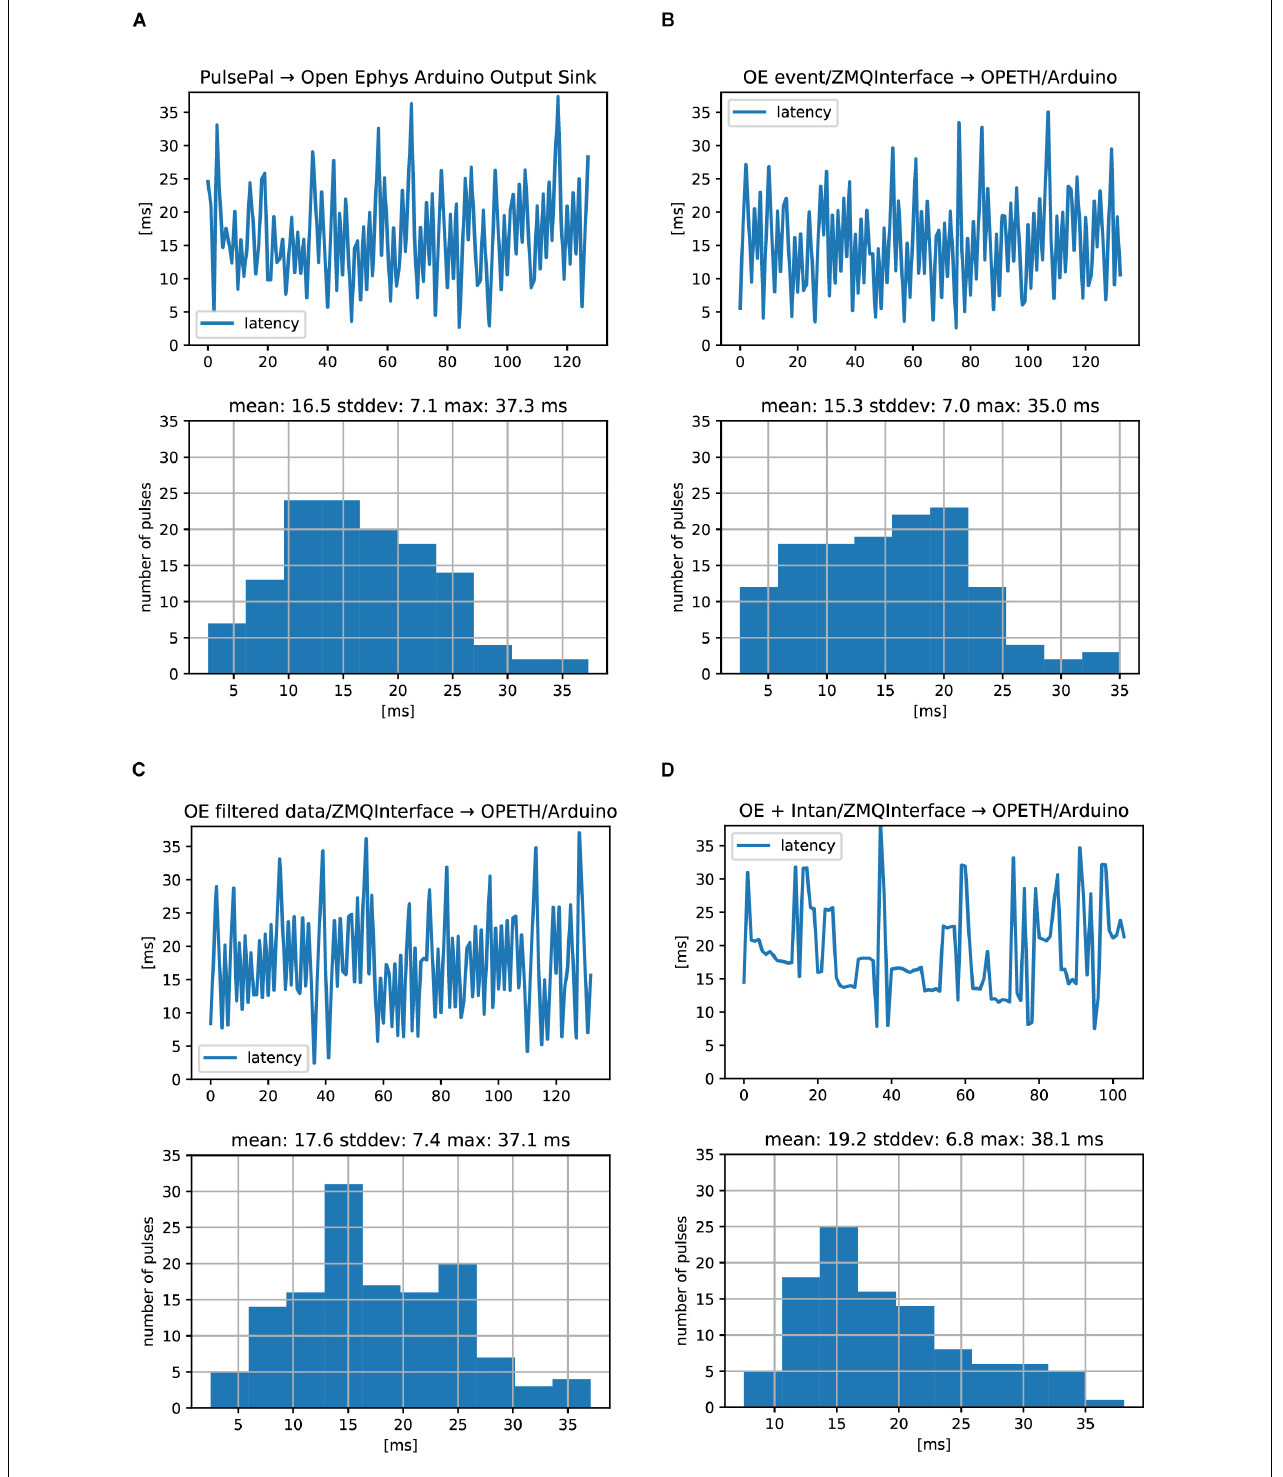
FIGURE 9 | Open Ephys analog and digital signal chain latencies. Oscilloscope delays were measures between an input TTL pulse and the generated response TTL. (A) Serially performed latency measurements (top) and histogram of latency values (bottom) corresponding to the setup in Supplementary Figure S3A . (B) Same measurements for the setup in Supplementary Figures S3B . (C) Same measurements for the setup in Supplementary Figures S3C . (D) Same measurements for the setup in Supplementary Figure S3D . No differences between digital (A,B) and analog (C) signal processing were found. ZMQInterface (B–D) did not introduce long